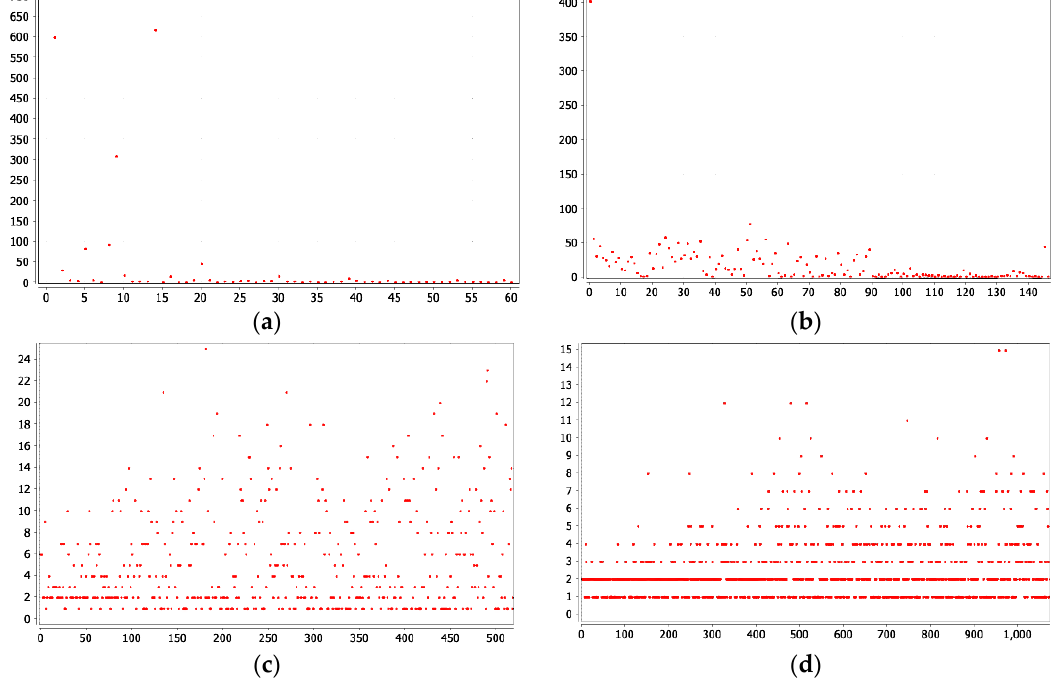
Figure 6. Modularity report results: ( a ) test 1; ( b ) test 2; ( c ) test 3; and ( d ) test 4.